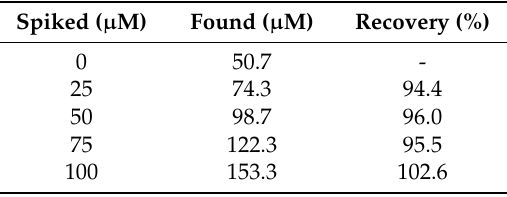
Table 2. The results of detecting glucose concentration in fruit